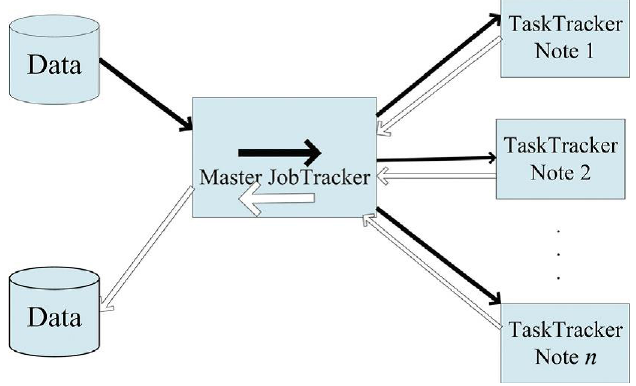
Fig. 5 MapReduce